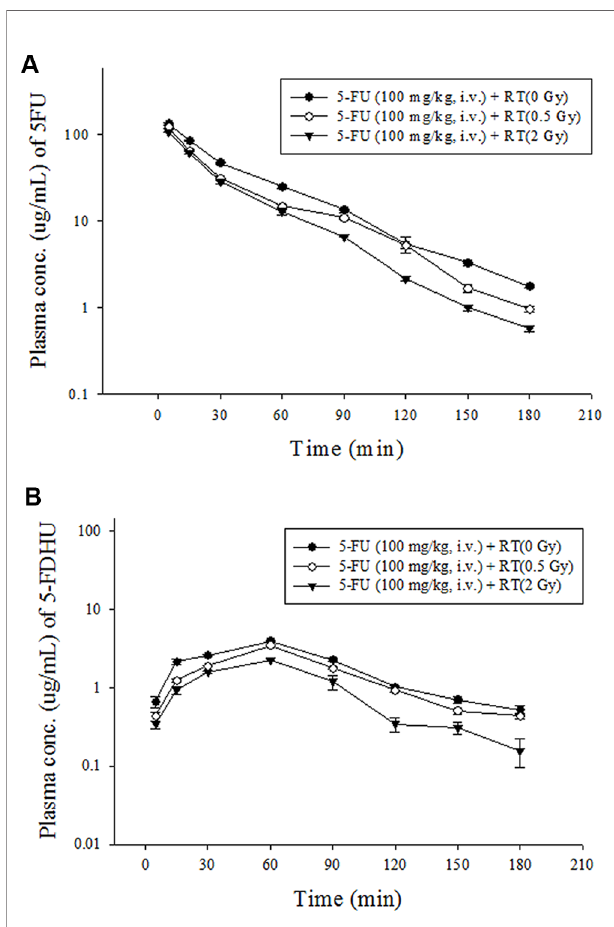
FIGURE 3 | (A) Mean plasma concentration-time curve of 5-FU ( (cid:129) ) in rat blood after 5-FU administration (100 mg/kg, iv) alone, 5-FU (100 mg/kg, i.v.) + RT (0.5 Gy) ( ○ ) and 5-FU (100 mg/kg, i.v.) + RT (2 Gy) ( ▼ ). (B) Mean plasma concentration-time curve of 5-FDHU ( (cid:129) ) in rat blood after 5-FU